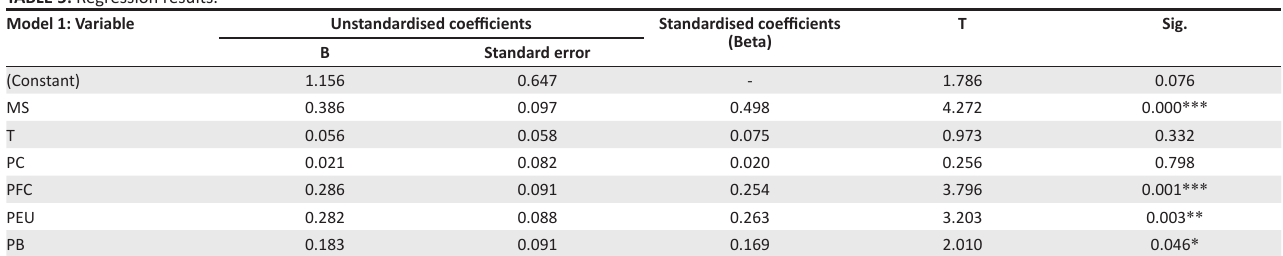
TABLE 5: Regression